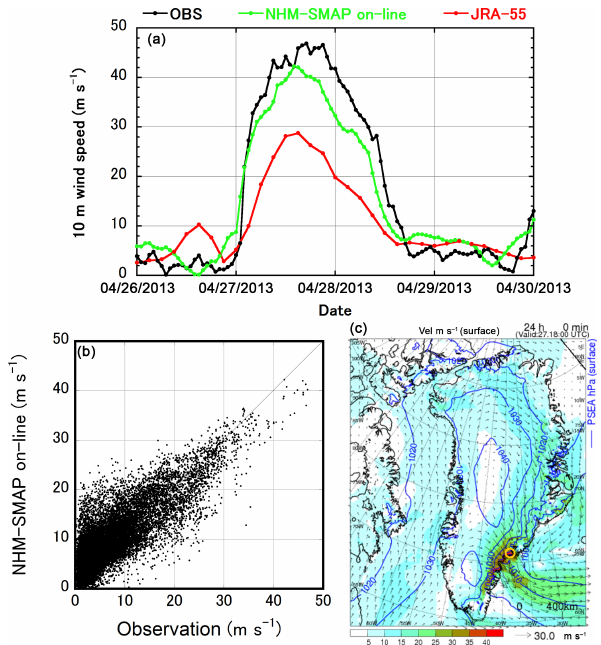
Figure 4. Model evaluation of hourly 10m wind speed at TAS_U. (a) Time series of observed and simulated 10m wind speed at TAS_U from 26 to 29 April 2013. Three-hourly interval 10m wind speed from JRA-55 is depicted. (b) Scatter plot of observed and simulated 10m wind speed at TAS_U during the study pe- riod. (c) Surface synoptic weather map for the model region at 17:00UTC on 27 April 2013 simulated by NHM–SMAP, showing surface wind speed (color), surface wind vector (arrows), and sea level pressure (contours, at 10hPa intervals). Yellow circle indicates the position of